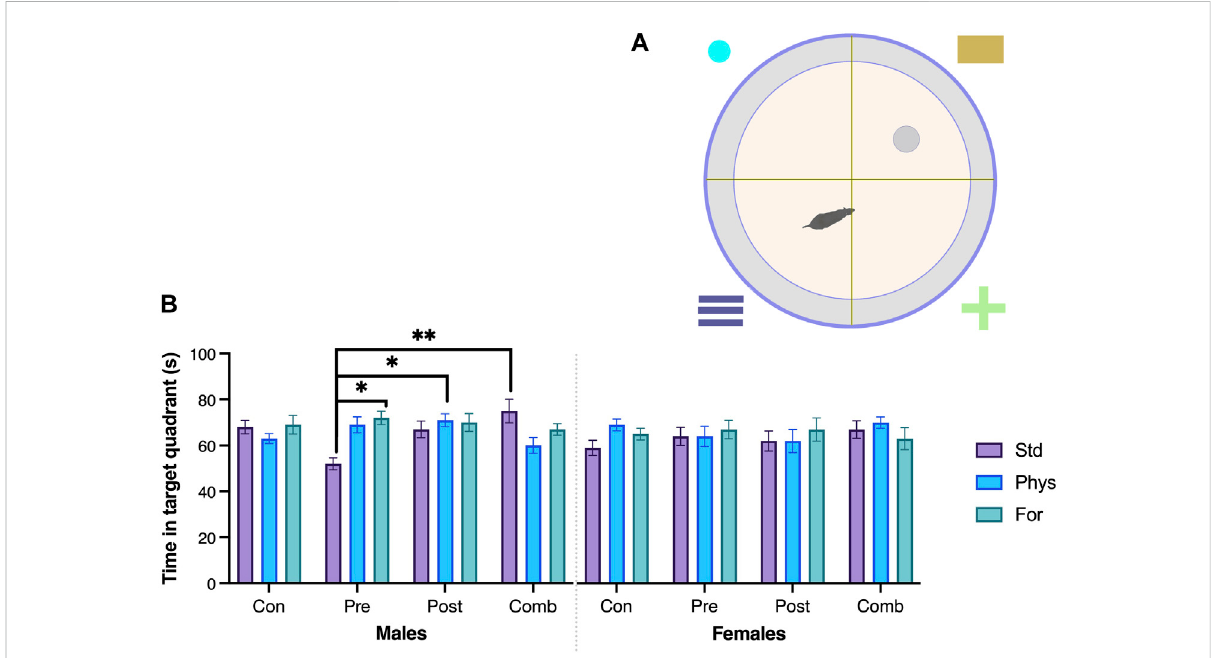
FIGURE 7 Spatialmemory — MorrisWaterMaze. (A) SchematicdrawingoftheMorrisWatermaze. (B) Time(seconds)inthetargetquadrant.Malesexposed to combined ELS with standard housing (n = 9) spent more time (seconds) in the target quadrant compared to males exposed to prenatal ELS with standard housing (n = 10). Males exposed to prenatal ELS housed with Foraging-EE (n = 8) spent more time (seconds) in the target quadrant compared to males exposed to prenatal ELS with standard housing (n = 10). Males exposed to postnatal ELS housed with Physical-EE (n = 13) spentmoretime(seconds)inthetargetquadrantcomparedtomalesexposedtoprenatalELSwithstandardhousing.ELS(n=10).Abbreviations:ELS, Early life stress; Con, Control; Pre, Prenatal; Post, Postnatal; Comb, Combined; EE: Std, Standard; Phys, Physical-EE; For, Foraging-EE. Three Way ANOVA (see Table 1 for statistical results): ** p < 0.01, * p <